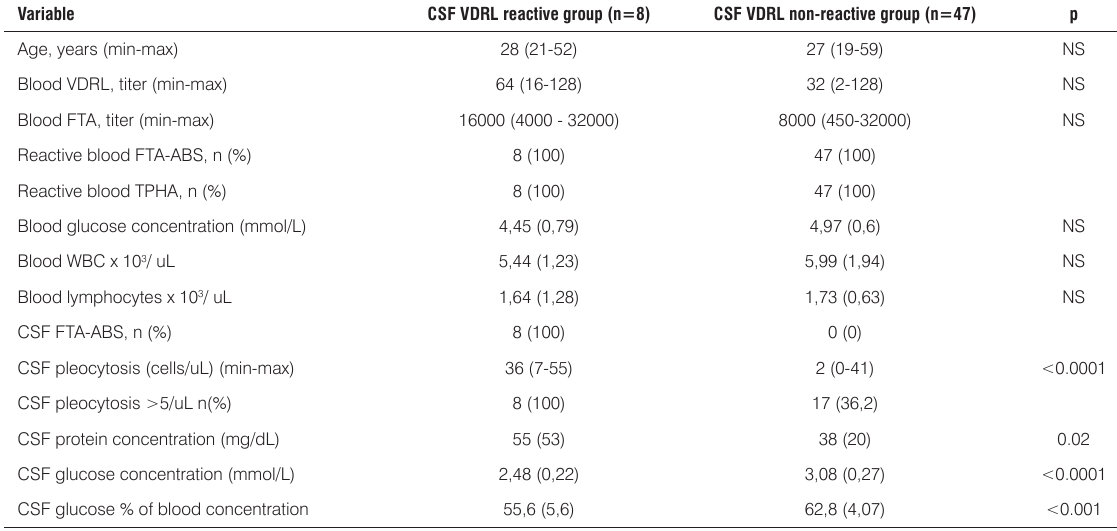
Table 1. Characteristics of